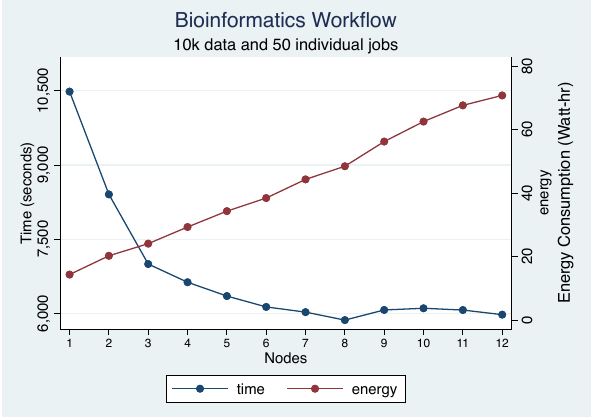
Figure 16. Bioinformatics Workflow—Time vs. Energy Consumption for 10 k.